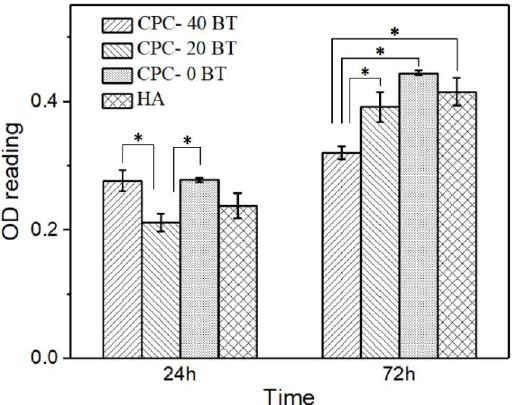
Figure 9. Optical density (OD) values of OB-6 pre-osteoblast cells seeded in extract of smart CPC-x BT formulations and HA for 24 h and 72 h, * refers to statistically different pair ( p < 0.05).